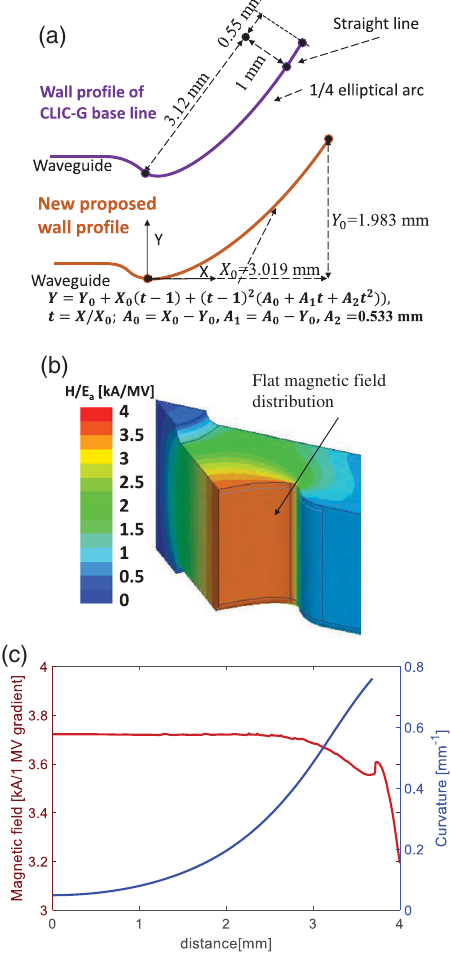
FIG. 6. (a) New proposed profile based on fourth order polynomial function ( 1 = 8 view). (b) Magnetic field distribution in the middle cell of CLIC accelerating structure with new proposed profile ( 1 = 8 view). (c) Curvature of the new proposed wall profile. FIG. 7. Surface flatness and rounding in the milling